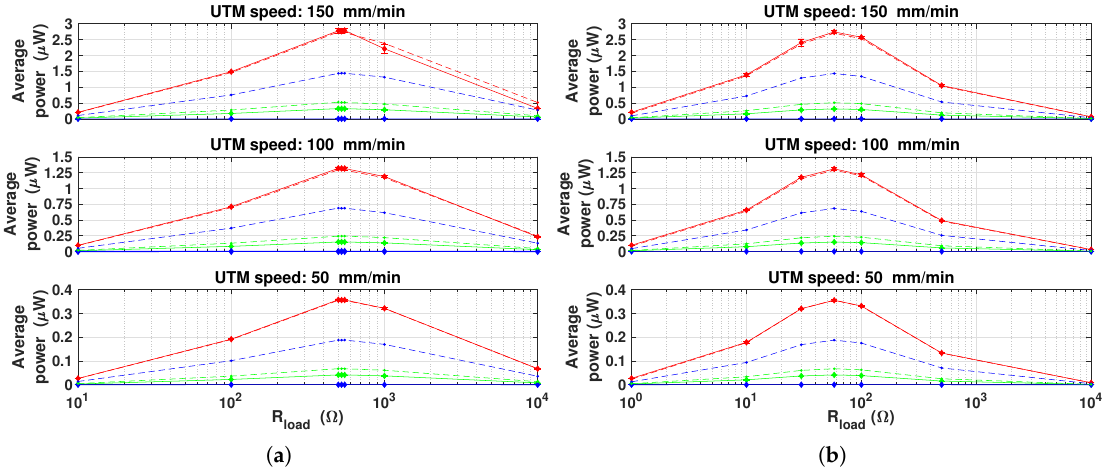
Figure 11. Comparison between the average measured (diamonds with solid line) and simulated (dots with dashed line) power vs. the applied electric load. PMs with different diameters are considered—10 (green), 15 (red) and 20 mm (blue). ( a ) Coils connected in series. ( b ) Coils connected in parallel.